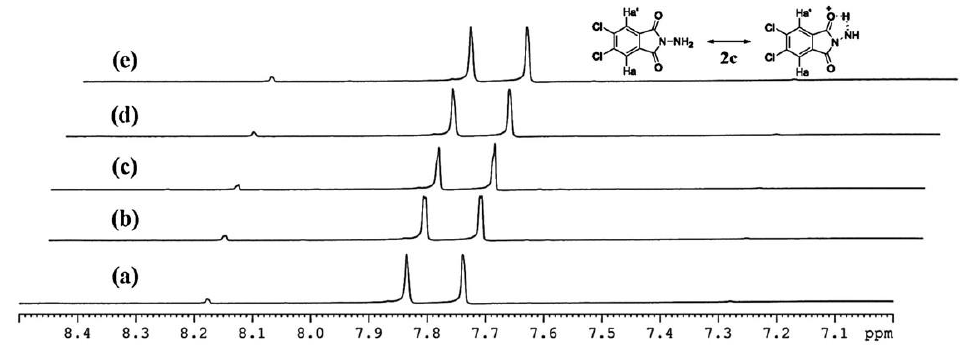
Figure 2. The timed programming result of N -aminophthalimides 2c of 1 H NMR spectra ( a ) 0 min, ( b ) 10 min, ( c ) 20 min, ( d ) 30 min, ( e ) 60 min.